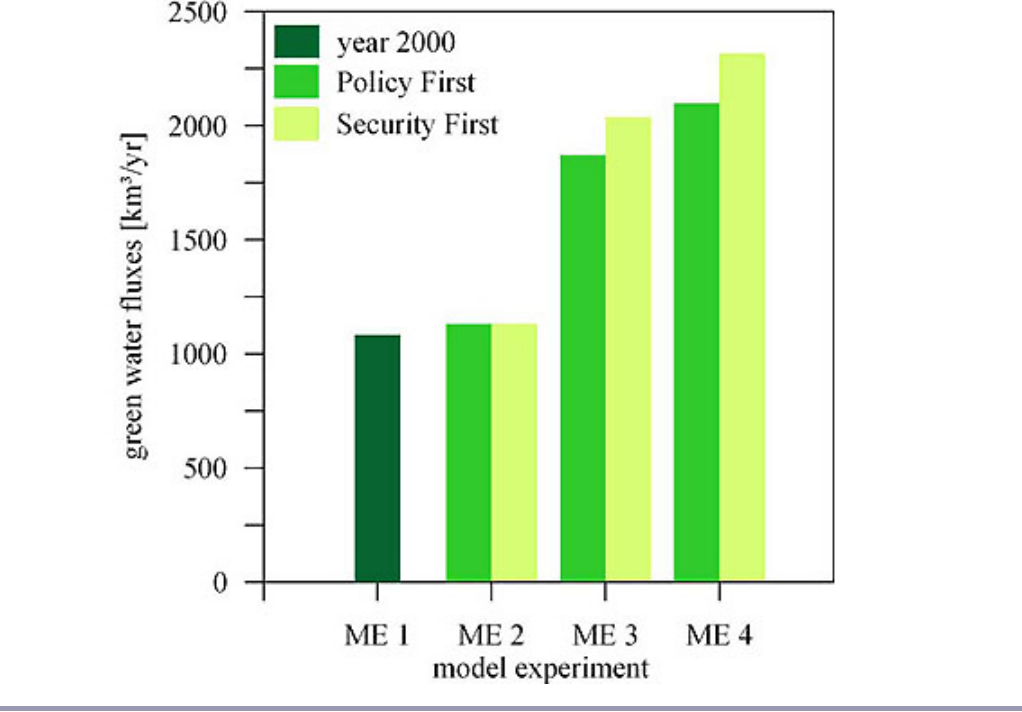
Figure 4. Continental green water fluxes from cropland. (For a description of the model experiments, see